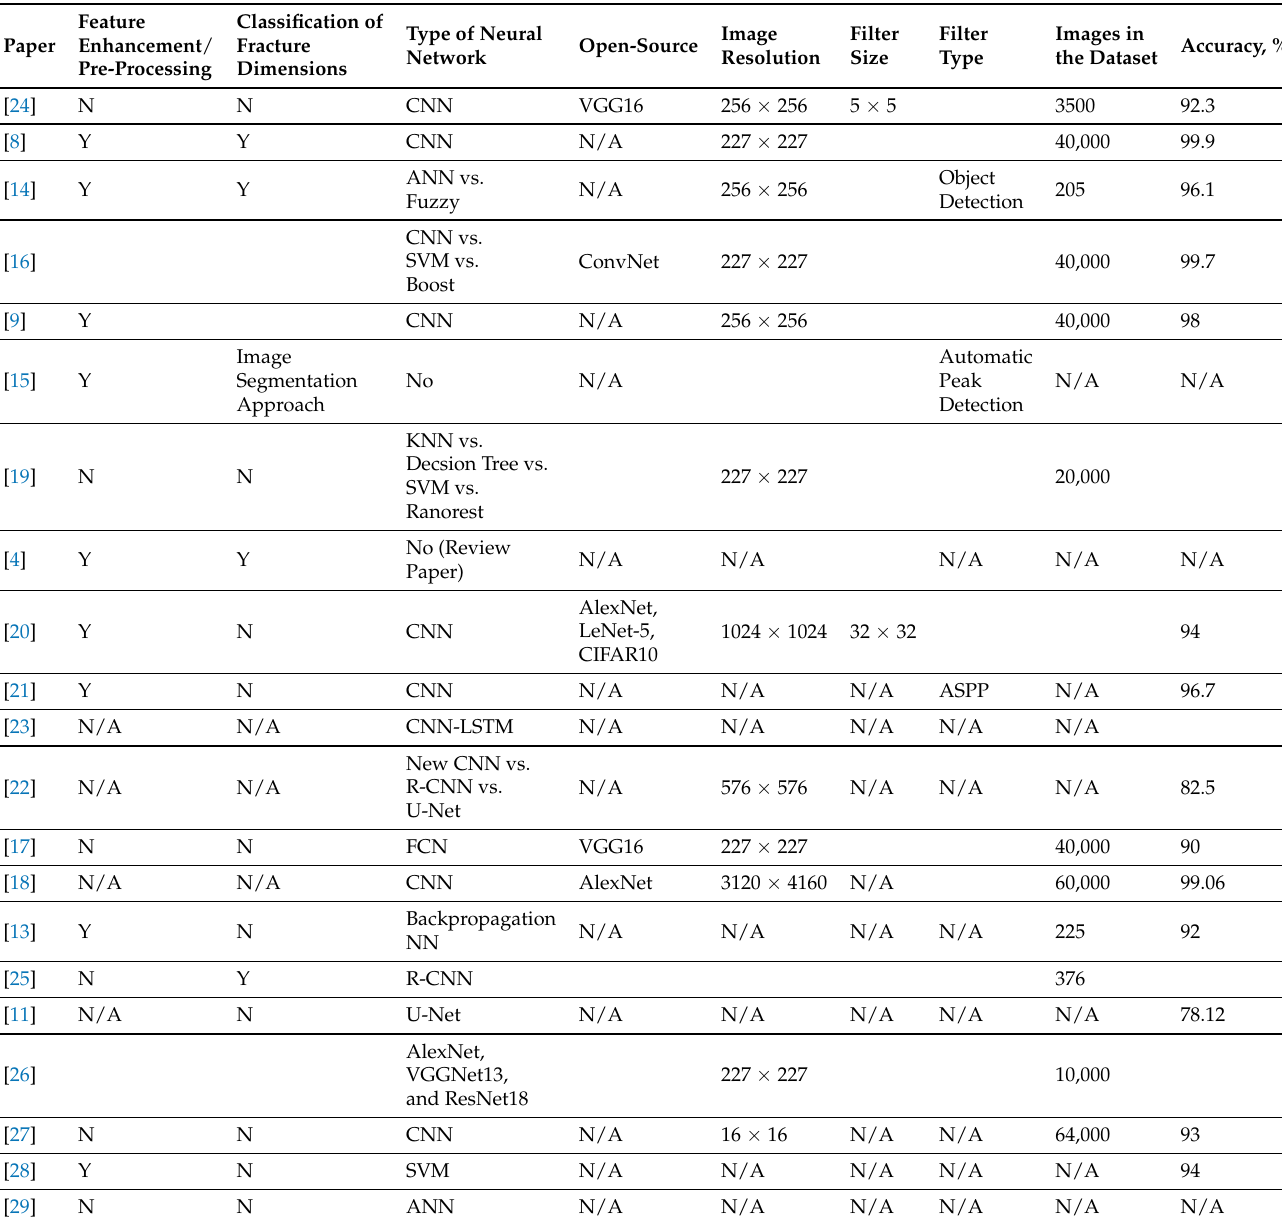
Table 1. The overview of image processing methods and application of neural networks for crack identification in concrete